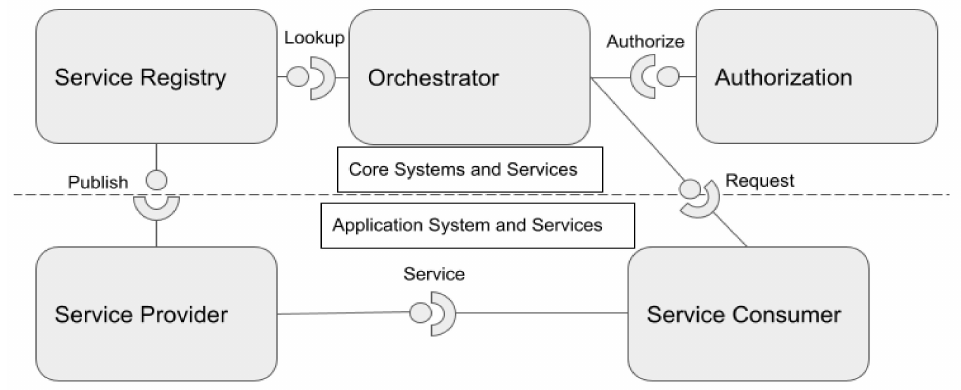
Figure 1. Outline of general architecture—Arrowhead